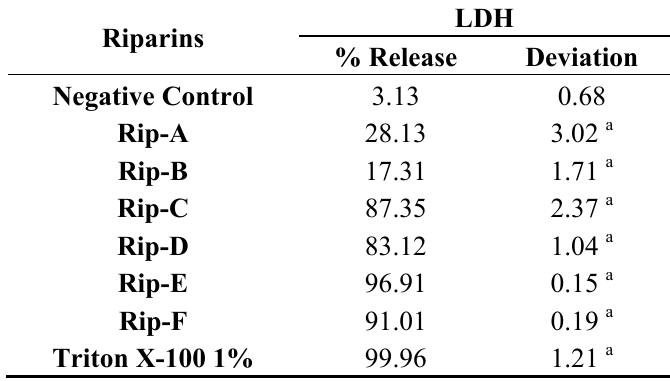
Table 6. Percentage of cytoplasmatic enzyme LDH releasing induced by riparins at concentration of 25 µg/mL on murine peritoneal macrophages RAW